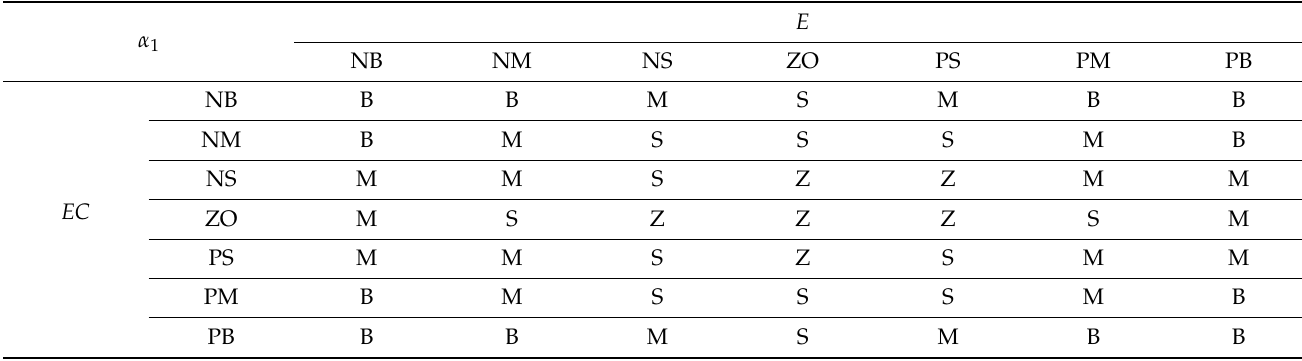
Table 4. Fuzzy rule base for α 2 .